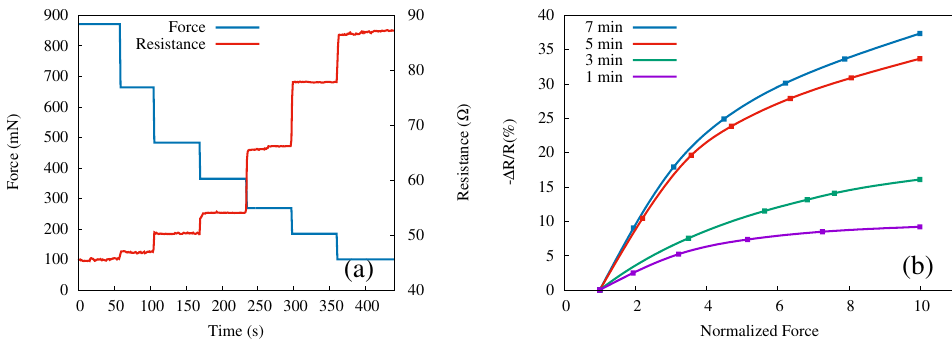
Figure 4. ( a ) Instantaneous resistance (right y -axis, red line) in response to applied force (left 4-axis, blue line) over time for sample D. ( b ) Relative resistance change versus normalized force for SiNWs samples A (purple), B (green), C (red), and D